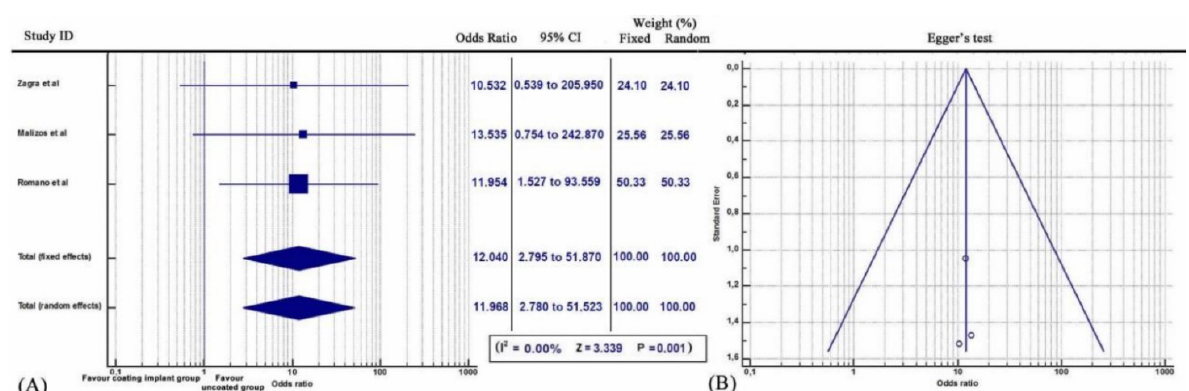
Figure 2. (A) Forest plot showing the likelihood of periprosthetic infections in each of the coating implant groups (Antibiotic, Silver and Iodine) versus the group without coating implants. (B) Funnel plot of the Egger’s test was utilized to assess for publication bias.